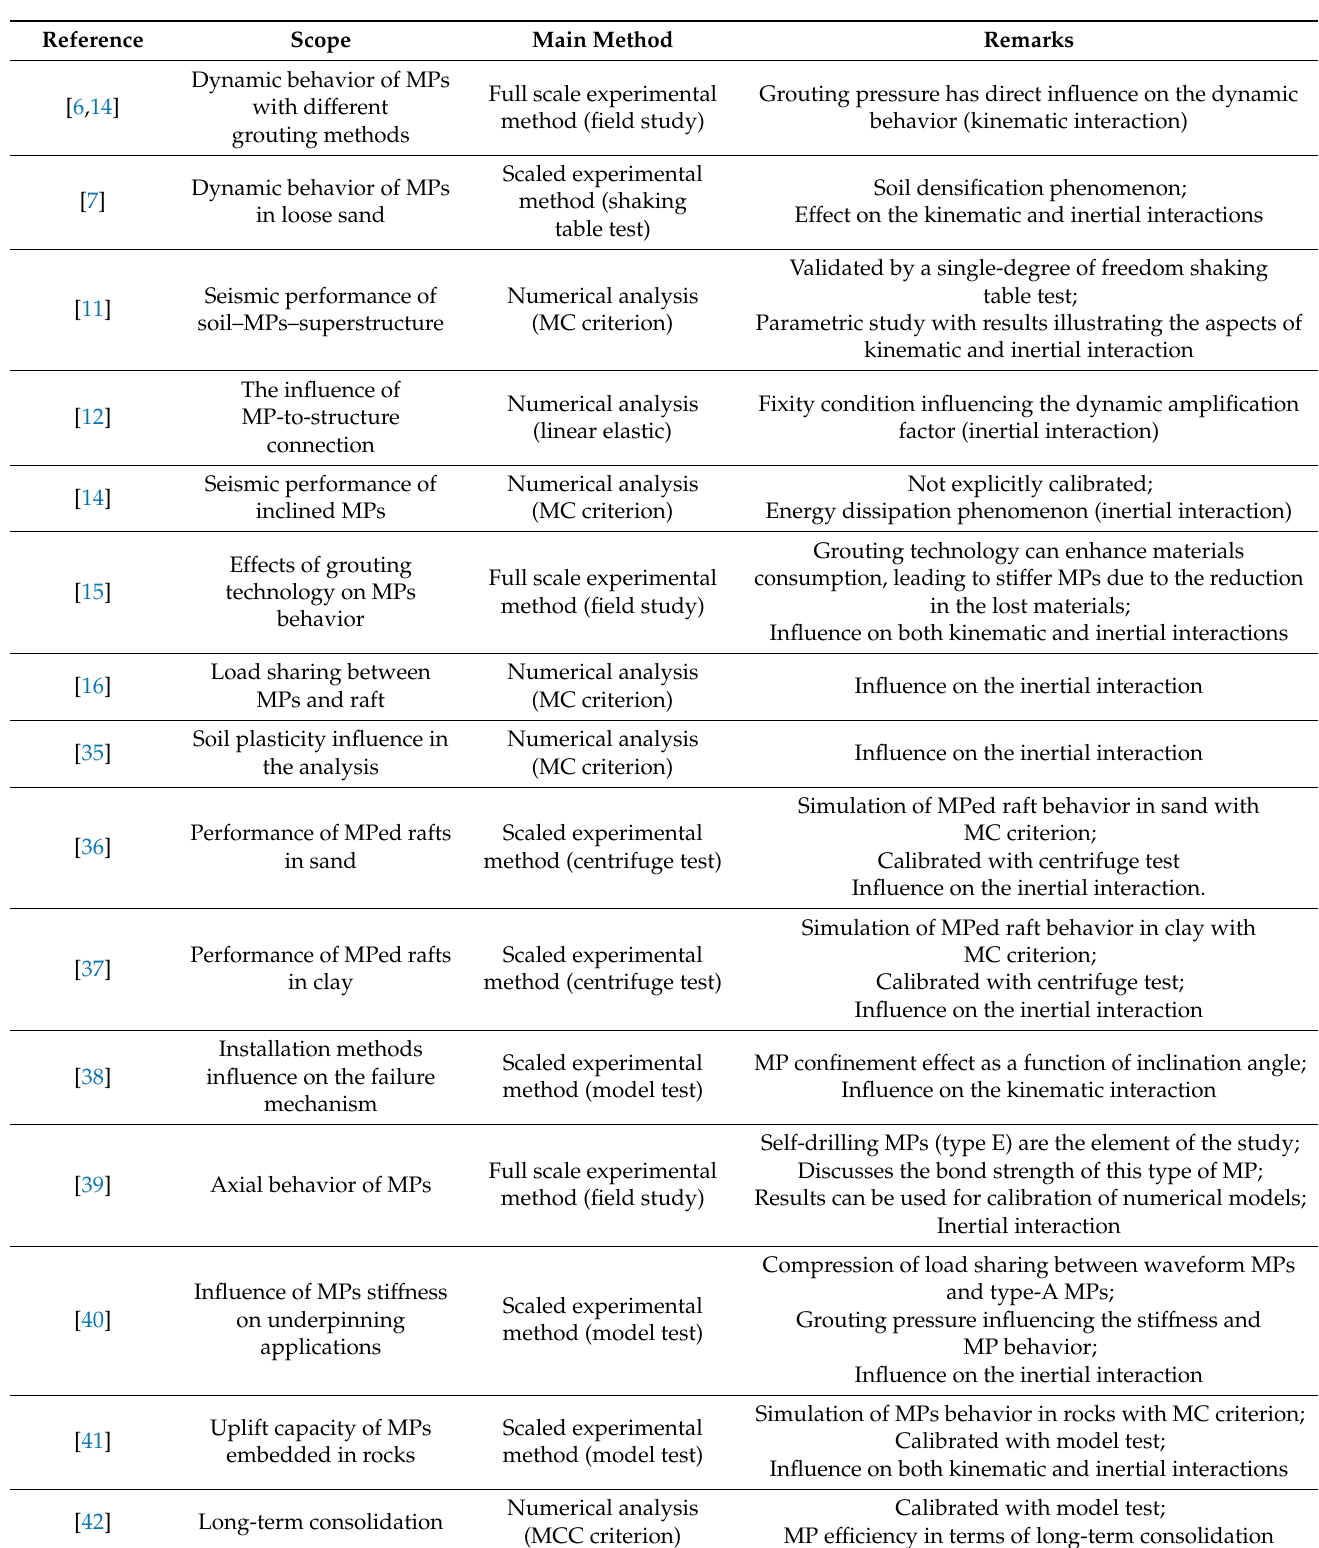
Table 4. Summary of selected papers concerning MP seismic